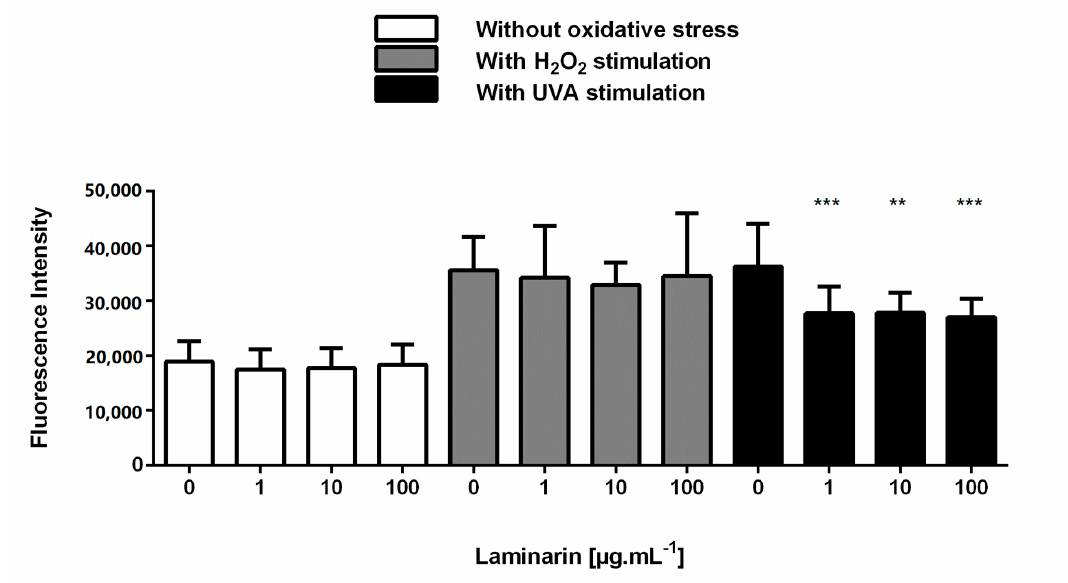
Figure A4. Effect of laminarin on oxidative stress. HaCaT cells were treated with 1, 10 and 100 µg.mL − 1 laminarin for 4 h. ROS production was induced by 0.5 mM of H 2 O 2 or by 365 nm, 0.42 J.s − 1 .cm² of UVA radiation. Free radical scavenging activity was evaluated using a DCFH-DA probe. Data are expressed as mean ± SD of three independent experiments. ** p ≤ 0.01, *** p ≤ 0.001 compared with 0 µg.mL − 1 (control group).